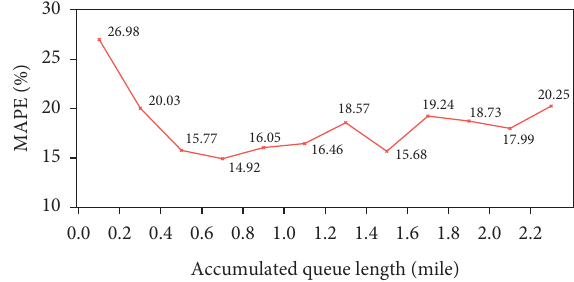
Figure 15: MAPE and RMSE in queue length intervals of 6-lane cases. The cross-point represents the average value in that